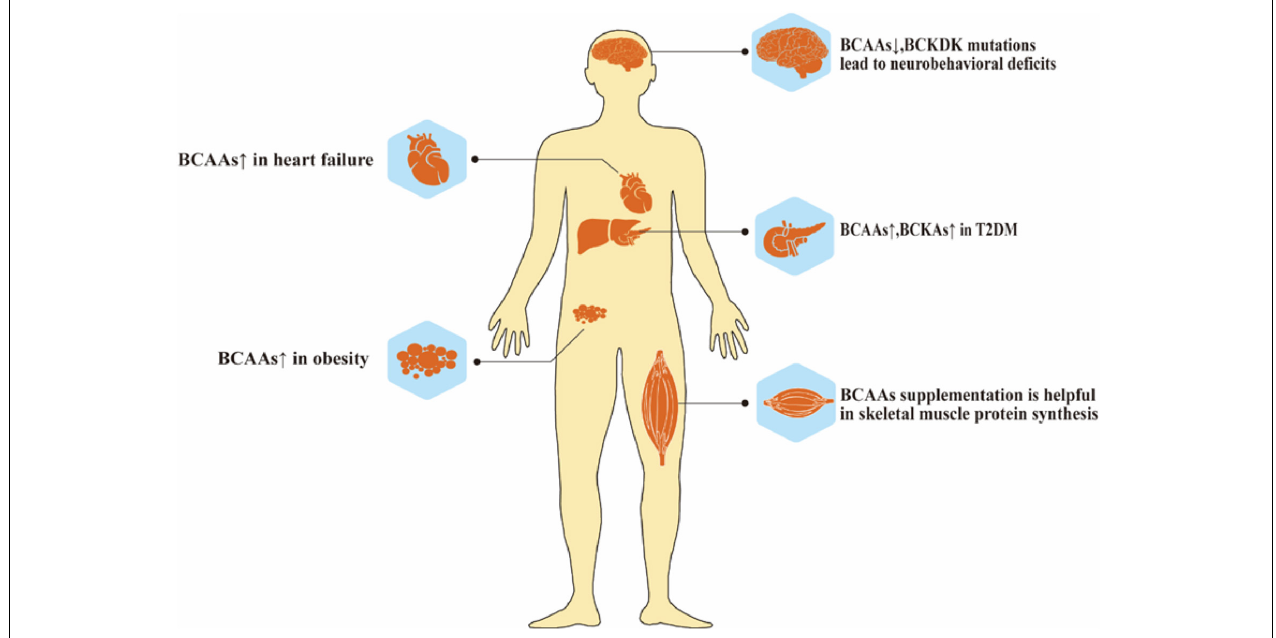
FIGURE 3 | Role of BCAAs metabolism in health. Abnormal elevation or deficiency of BCAAs lead to many diseases, such as neurobehavioral deficits, heart failure, T2DM and obesity.